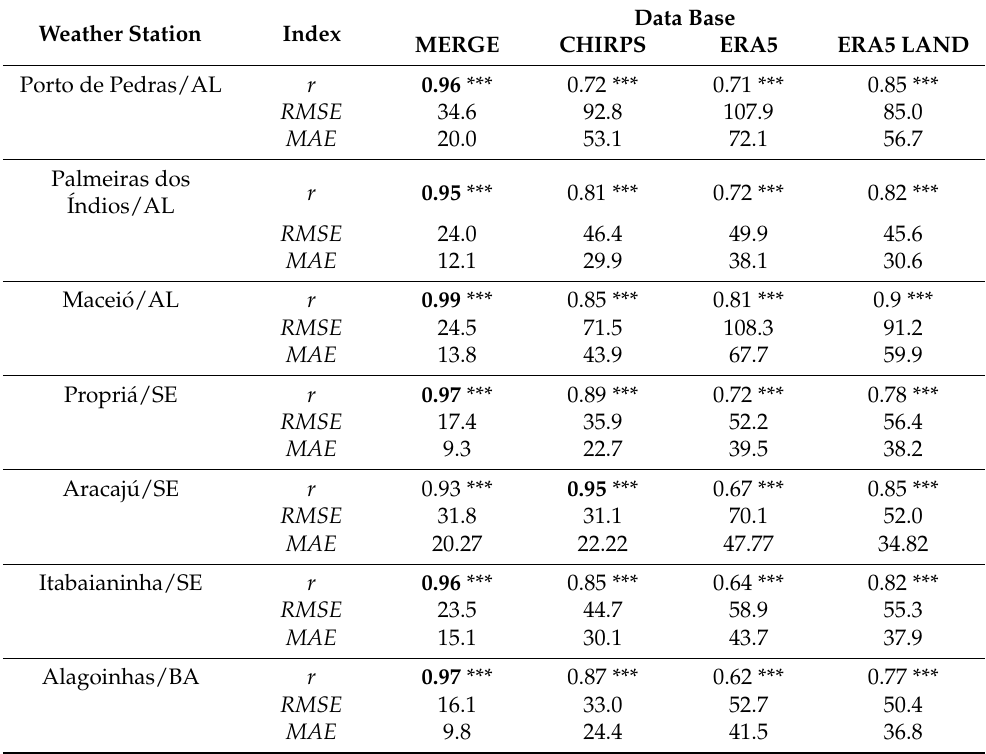
Table 2. Statistical analysis (Pearson correlation r , RMSE , and MAE ) on the monthly-accumulated precipitation from the different databases versus observations in the 2001–2020 period. The highest correlations are highlighted in